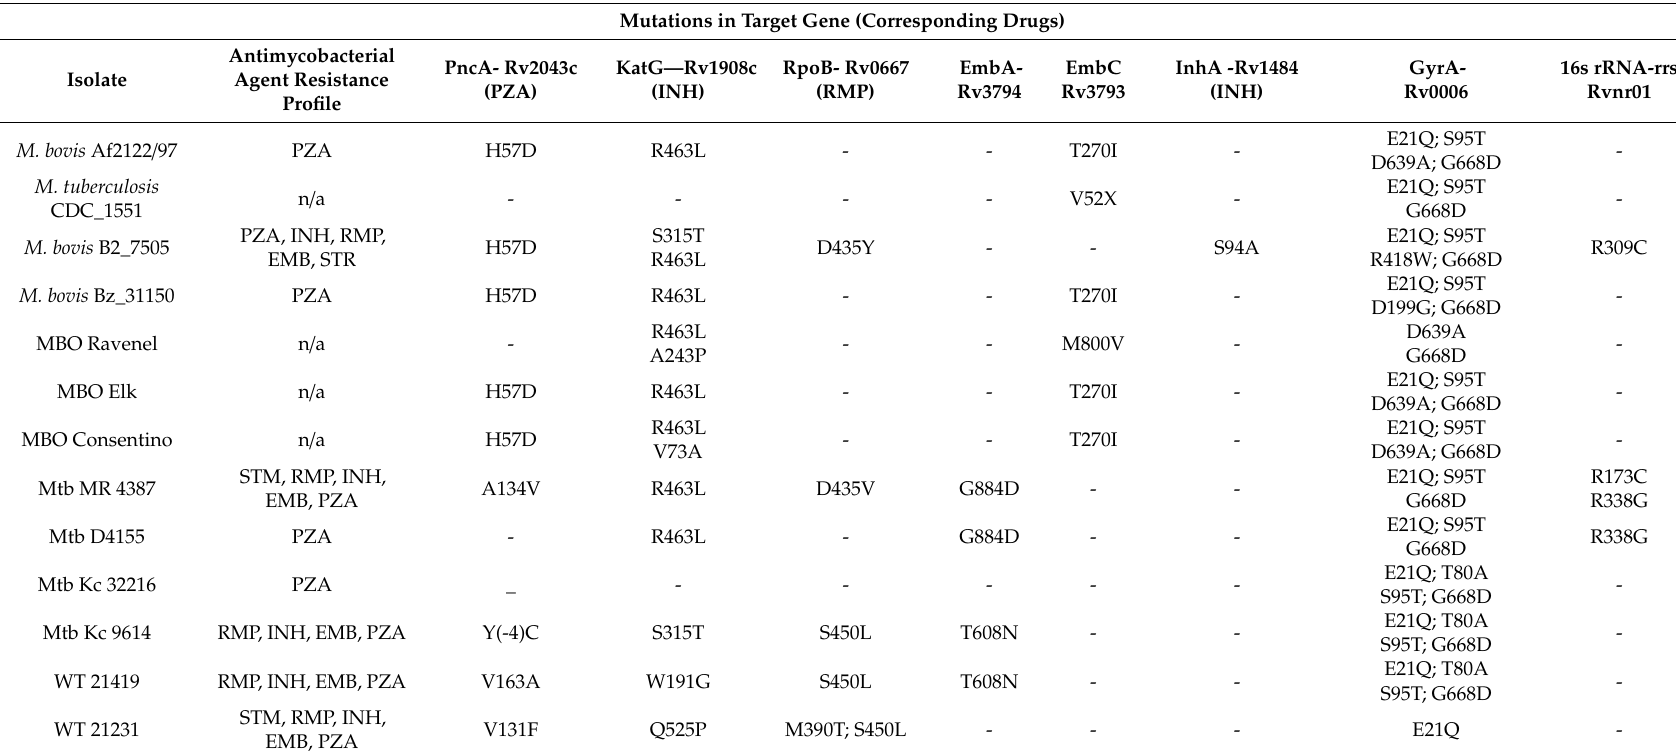
Table 7. Single nucleotide olymorphisms (SNPs) identified in antibiotic resistance associated regions in Mycobacterium tuberculosis complex isolates. Mutations in Target Gene (Corresponding